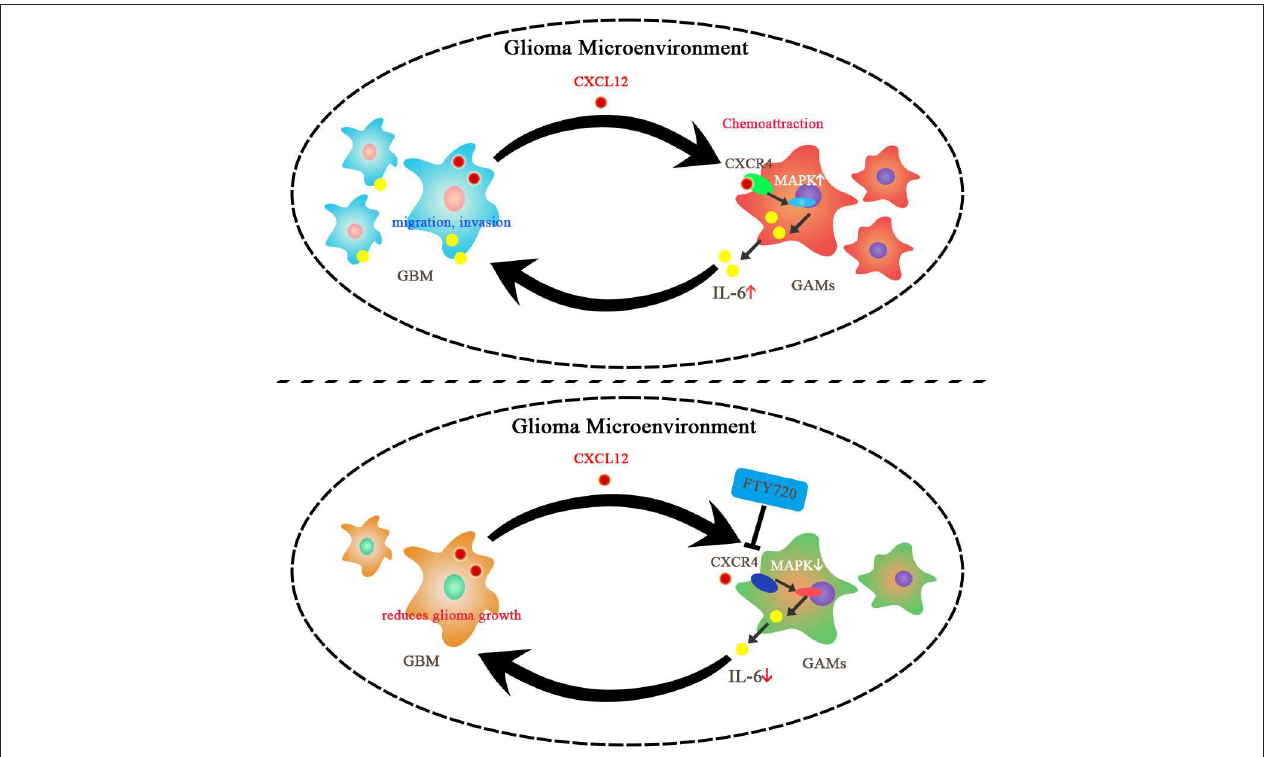
FIGURE 6 | Summary of the impacts of FTY720 on glioma microenvironment. GBM can secrete CXCL12 to activate CXCR4 on the GAMs, which results in chemoattraction of GAMs and support for glioma growth. FTY720 treatment can induce CXCR4 internalization on GAMs, and thereby inhibit MAPK-mediated IL-6 secretion and suppress migration and invasion of